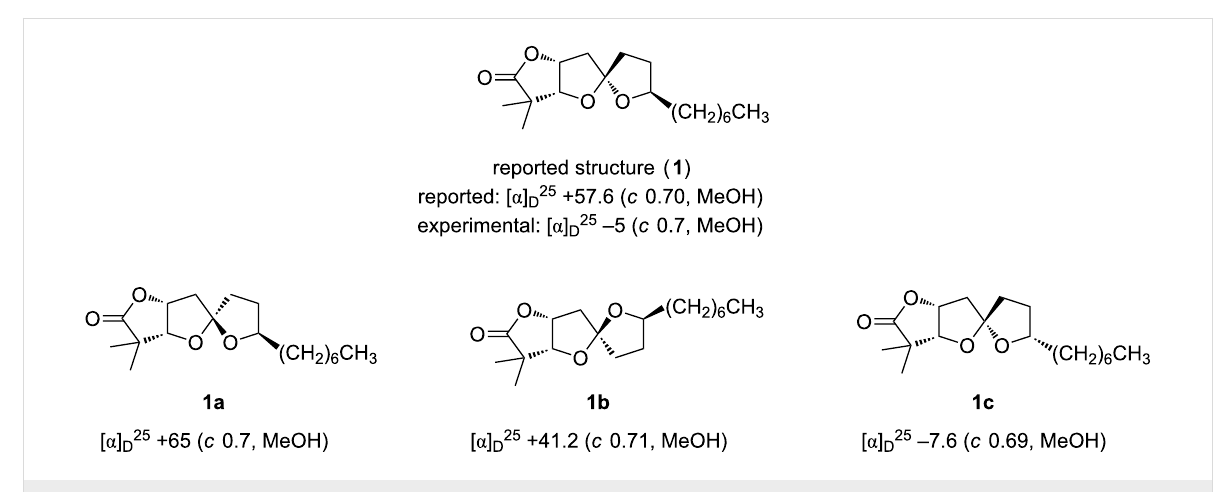
Figure 3: Reported and synthesized cephalosporolide H